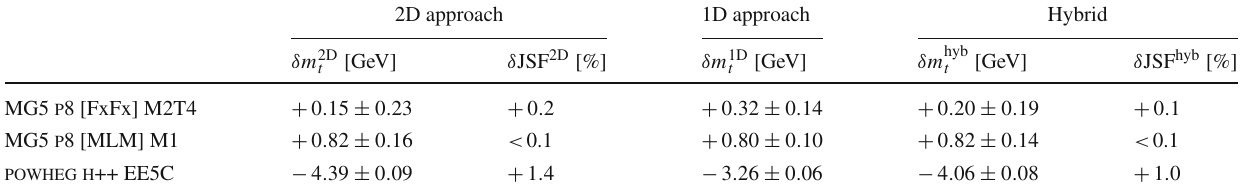
Table 2 Observed shifts with respect to the default simulation for different generator setups. The statistical uncertainty in the JSF shifts is